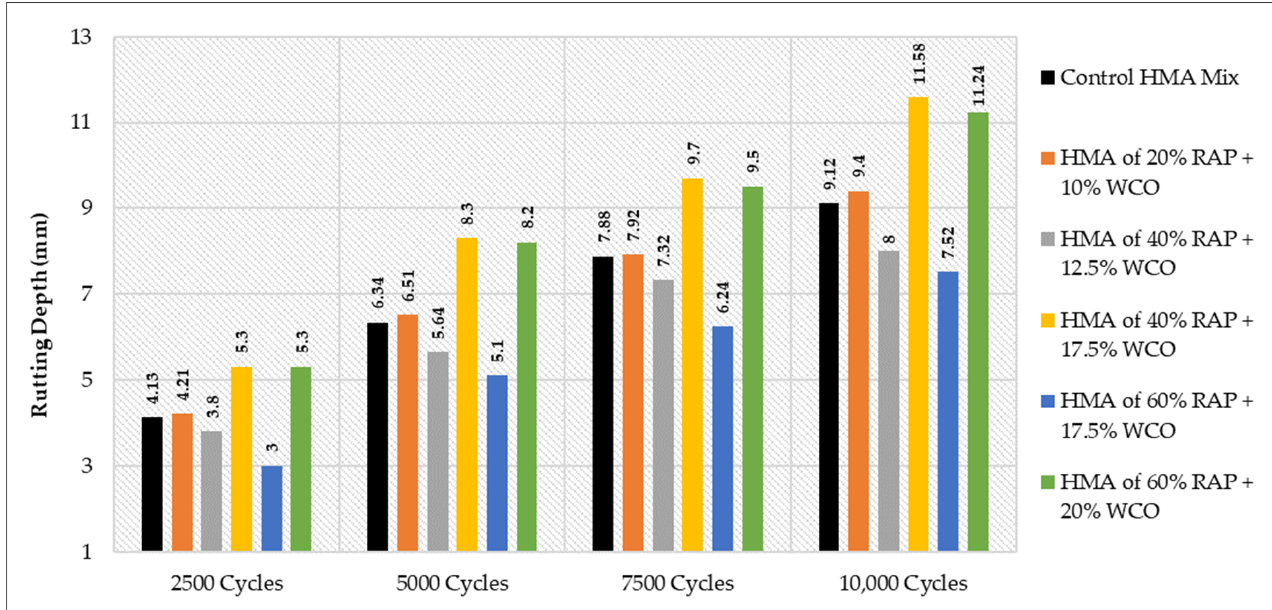
Figure 25. Rutting depths of recycled HMA mixtures rejuvenated by WCO.